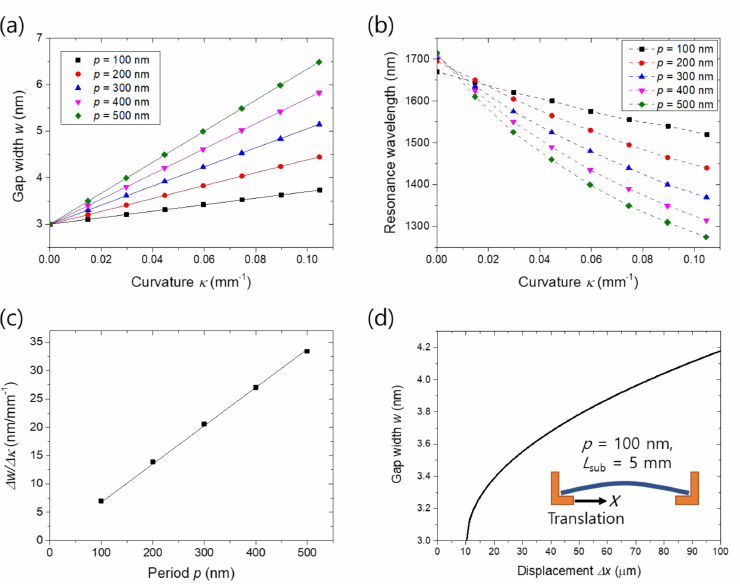
Figure 6. Effect of the slit period on the active width control: ( a ) Gap width versus substrate curvature for slit periods of 100, 200, 300, 400 and 500 nm; ( b ) Resonance wavelength as a function of the curvature for the various slit period; ( c ) ∆ w / ∆ κ , the slope in ( a ), versus slit period; ( d ) Gap width versus displacement of the supporting stage for the case of p = 100 nm when the substrate length is 5 mm. Solid lines in ( a ) and ( c ) are linear